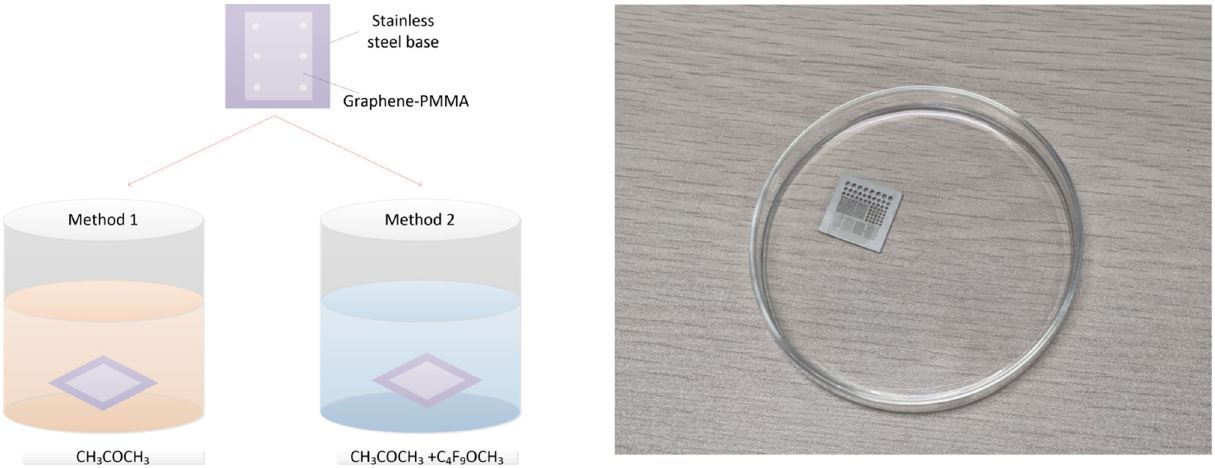
Figure 6. The schematic diagram of two conventional dipping methods to remove the PMMA.